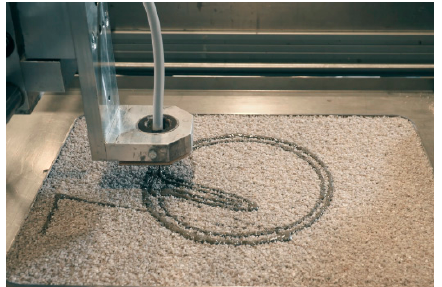
Figure 2. Selective paste intrusion (SPI) printer used for the investigations [36].